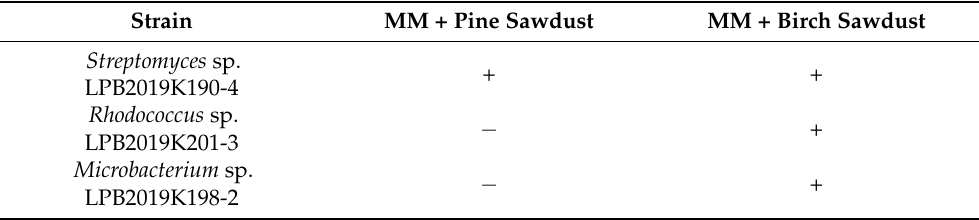
Figure 2. Evolutionary relationships of the Baikal strain of Rhodocuccus sp. The phylogenetic tree was constructed using the Neighbor-Joining method. The Baikal strain is marked with the “o” symbol. Table 1. Ability of isolated strains to grow on sawdust